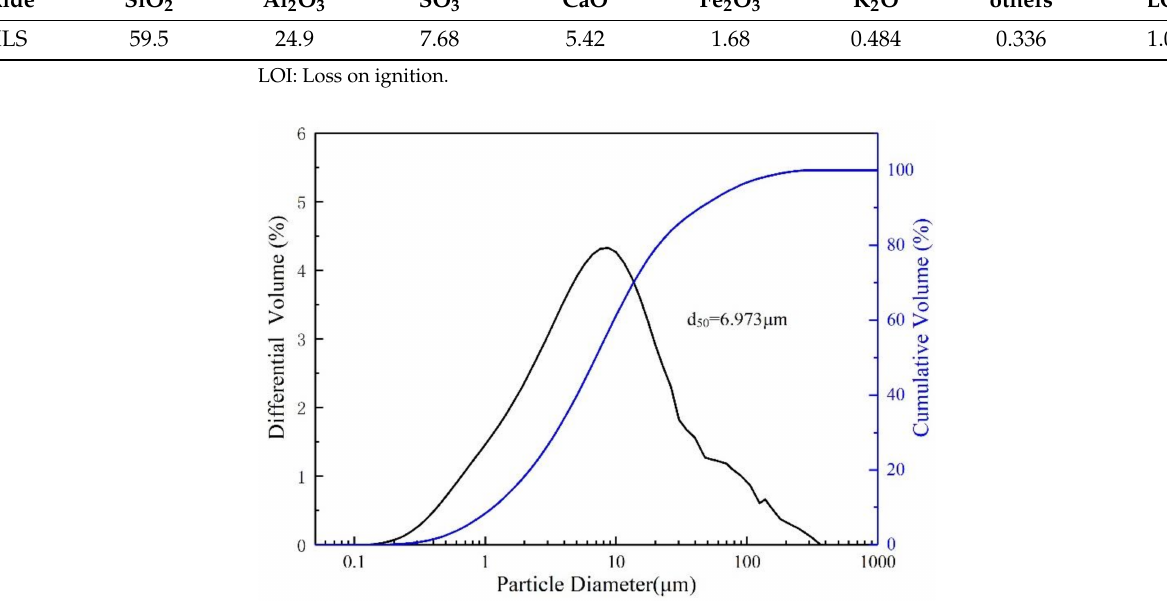
Figure 1. Particle size diameter distribution of